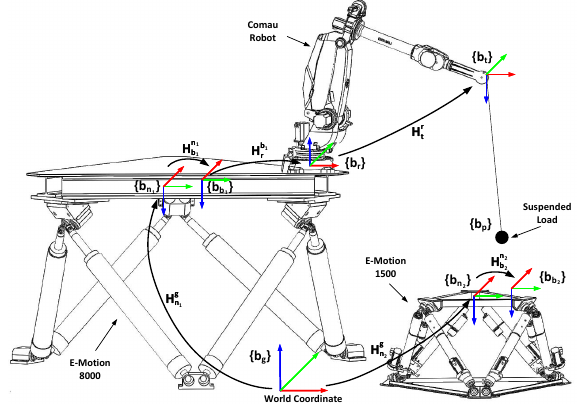
Figure 17: An overview of the experimental motion system setup, with body-fixed coordinate systems and